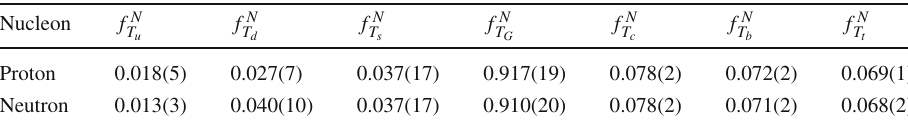
Table 3 Values of the f N